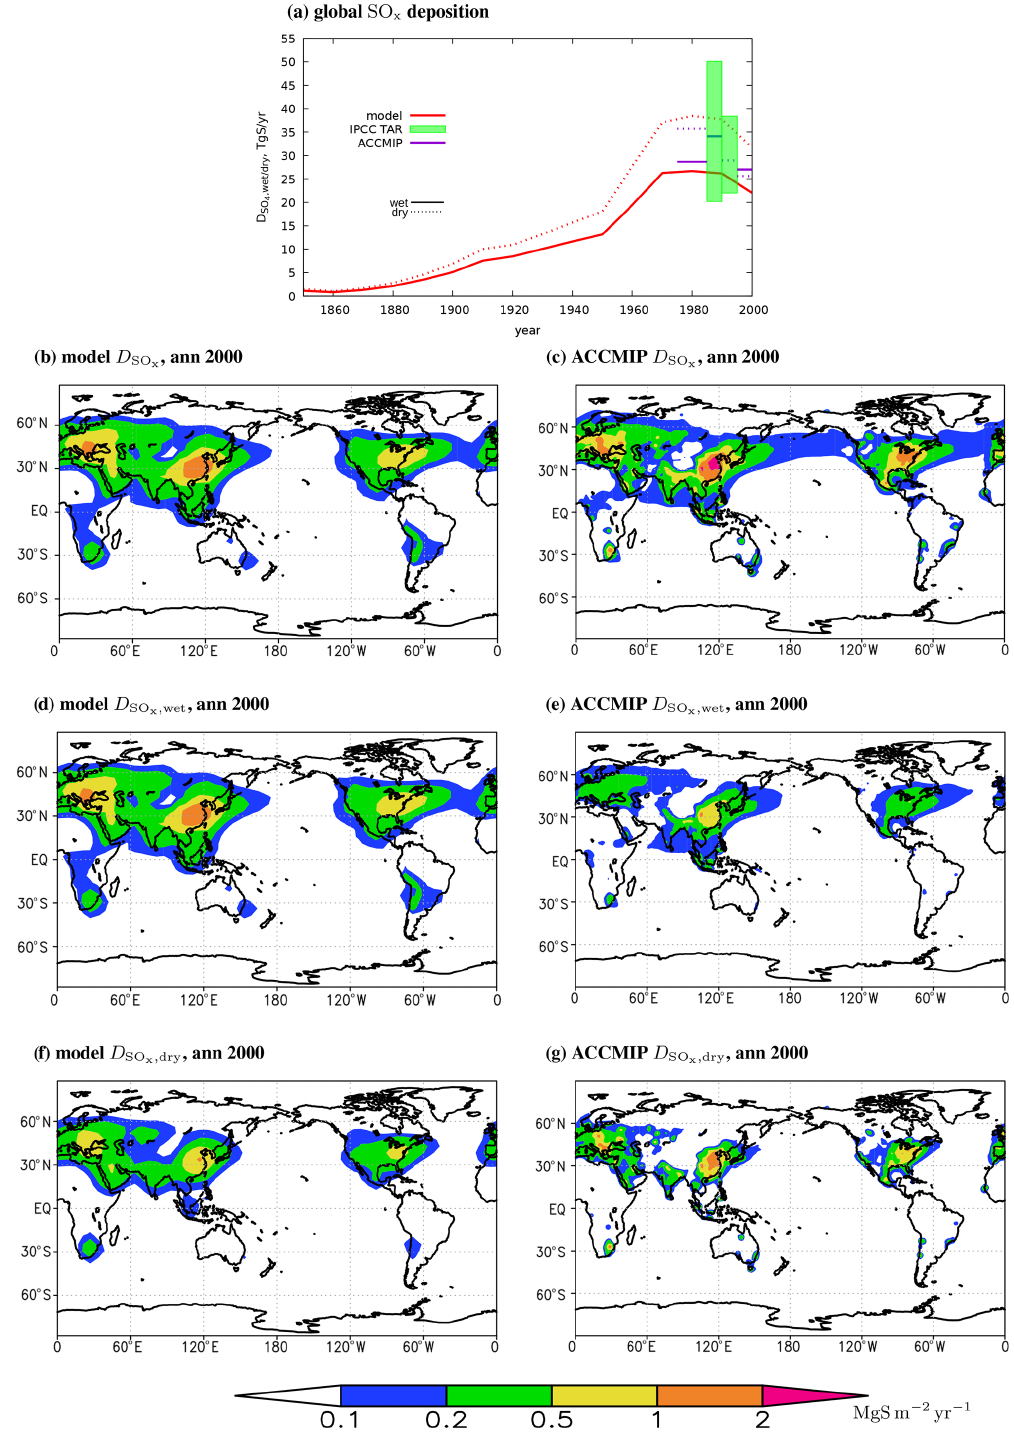
Figure 9. Global SO x deposition (a) and total (b, c) , wet (d, e) , and dry (f, g) SO x depositions per unit area in the model (b, d, f) and in the ACCMIP phase II simulations (c, e, g) for the year 2000. In (a) , horizontal lines on the colour boxes depict corresponding medians. The ACCMIP data are taken from Lamarque et al. (2013a). The IPCC TAR data are adopted from their Table 5.5 and are emission-rescaled (see text); their dry and wet contributions are plotted at different 5-year intervals near the year 1990 for visual purposes.